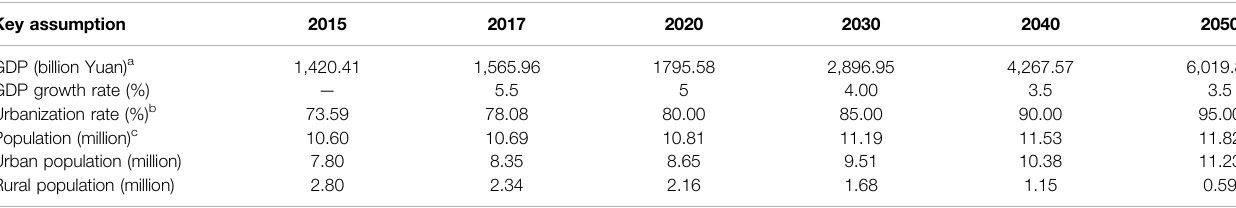
TABLE 1 | Basic assumptions of key macroeconomic